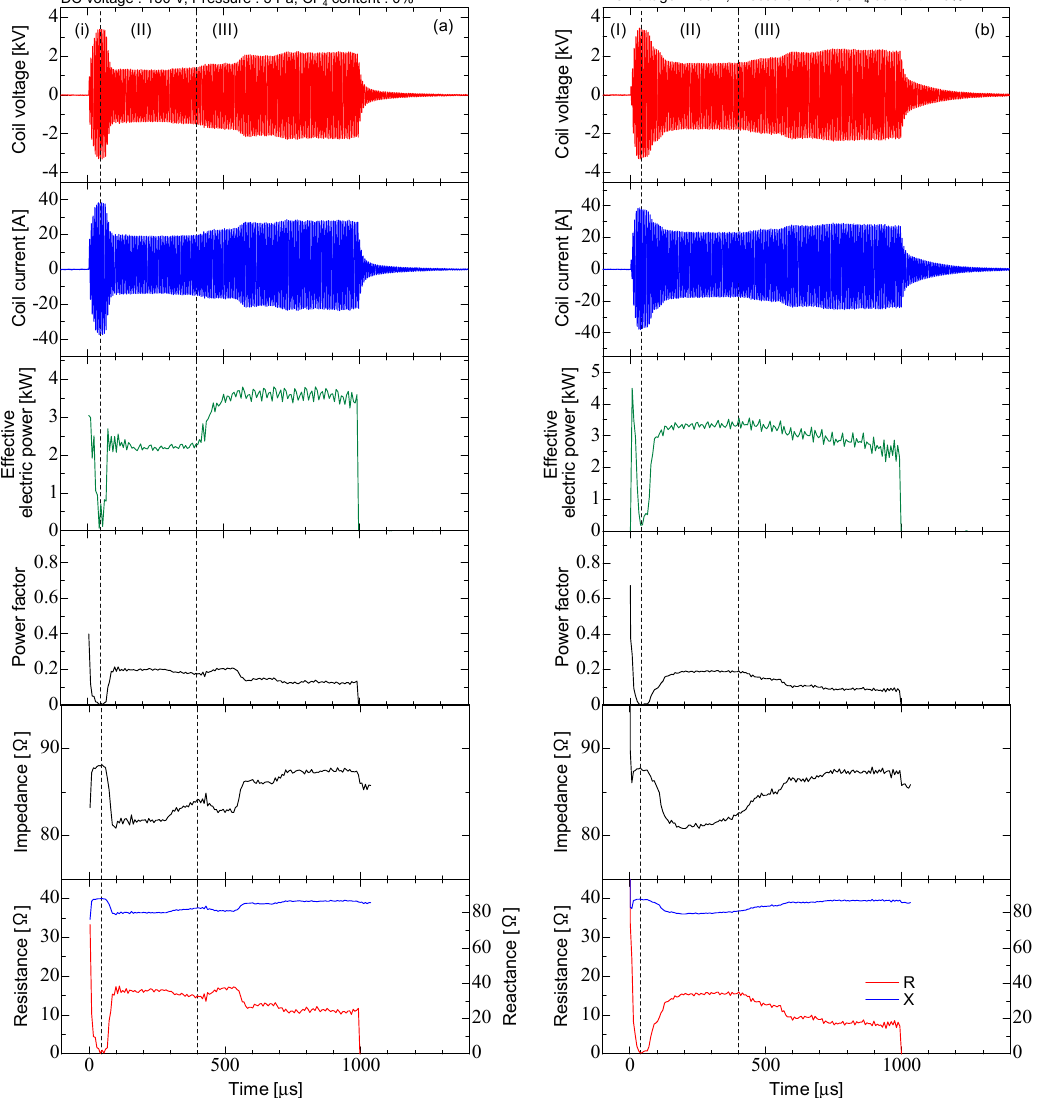
Figure 3. Typical waveforms of the coil voltage, coil current, the time evolution of the effective electrical power, the power factor, the impedance, the resistance and the reactance. ( a ) Ar discharge and ( b ) Ar/CF 4 discharge ( I ) before discharge, ( II ) constant discharge, ( II )